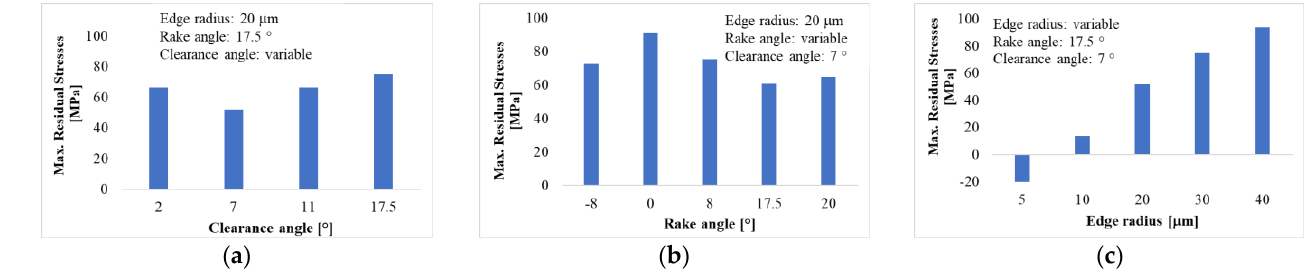
Figure 24. Effects of tool geometry on maximum residual stress: ( a ) clearance angle, ( b ) rake angle, and ( c ) nose radius.